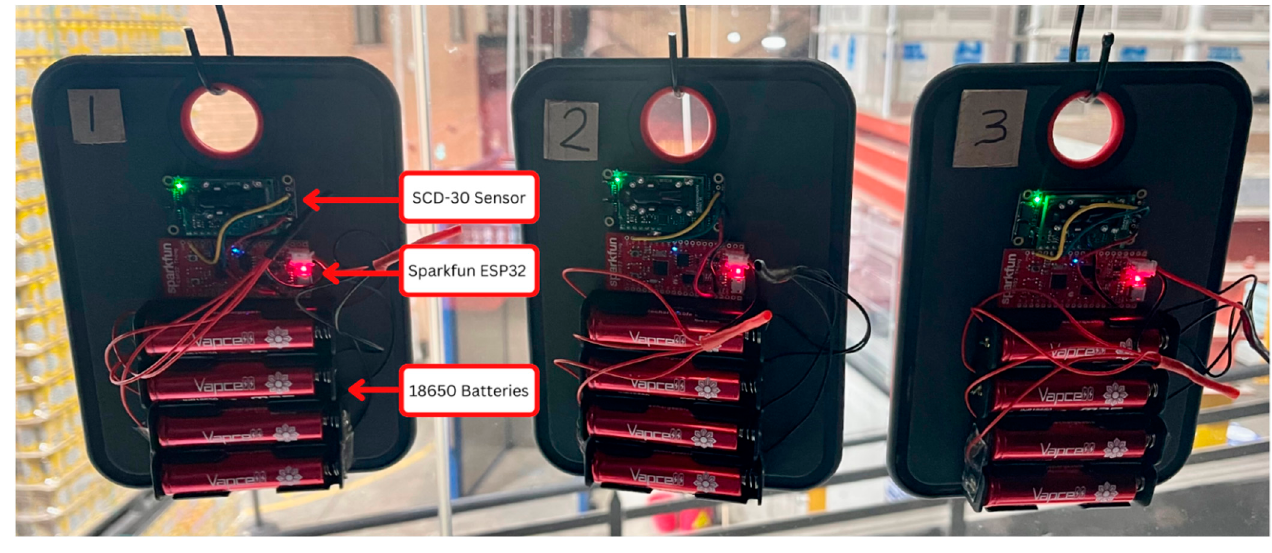
Figure 3. IoT CO 2 sensor nodes 1–3.